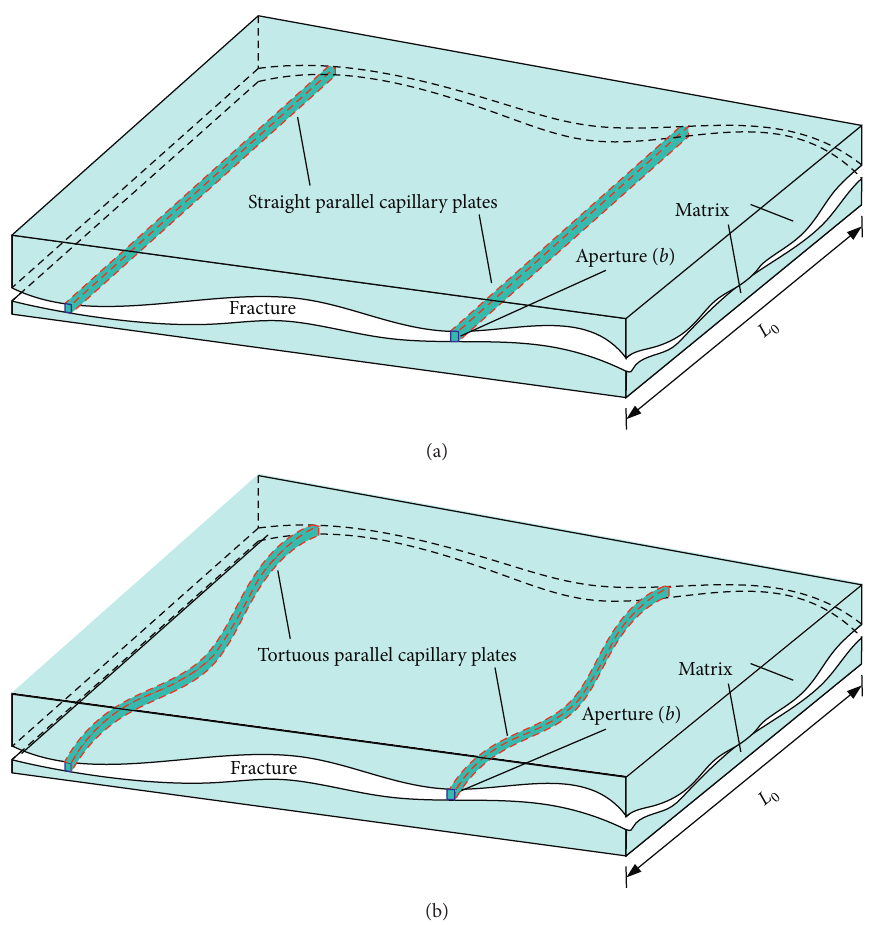
Figure 1: Schematic of capillary plate flow model with different apertures. (a) The straight parallel capillary model. (b) The tortuous parallel capillary